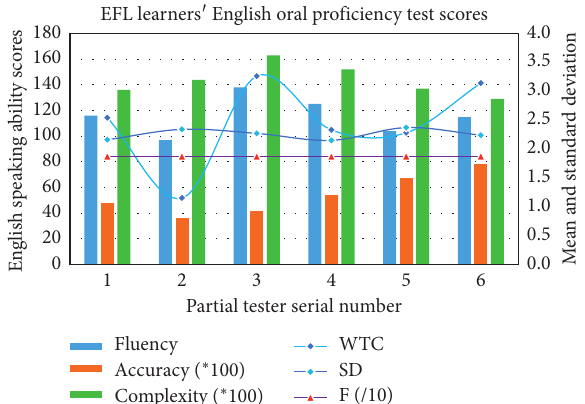
Figure 3: EFL learners’ English oral proficiency test scores.